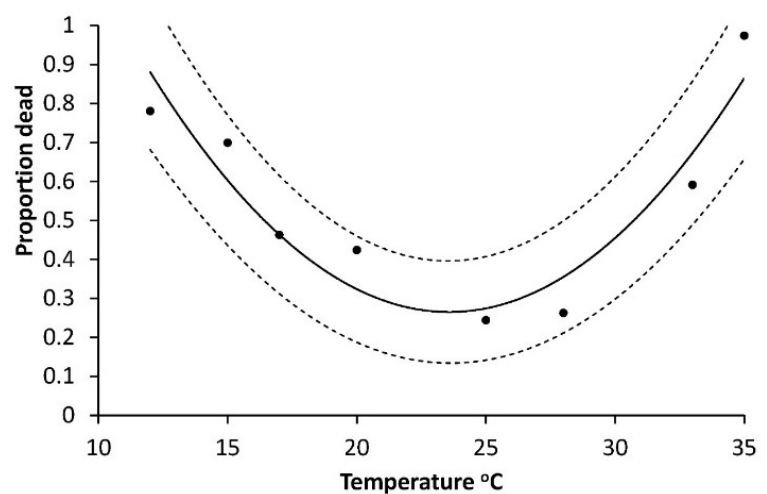
Figure 2. Proportion mortality through of all larval instars (from neonate until pupation) of Agrotis segetum at eight different temperatures. Proportion dead = 2.81957 − 0.2167T + 0.0046T 2 , R 2 = 0.874, F = 17.36, p = 0.0056. The dashed lines above and below represent the upper and lower 95% confidence bands. As it was difficult to categorize a tiny larva as moribund or dead, all moribund larvae were recorded as dead first instars, further supported by lack of head capsules from moulting, and only the precise time of death cannot be given. In contrast, the major mortality at 35 ◦ C was easily observed to take place in the pre-pupal phase. The pupal development rate (R pupa ) also depended strongly on temperature: R pupa = 0.02252 + 0.0040T ( ◦ C), R 2 = 0.925, F = 62.02, p = 0.0005 (Figure 3). This rate was without influence of sex as there was no difference between the two sexes (F = 0.12, p = 0.7397). The base temperature (T 0 ) for pupal development was 5.61 ◦ C and 250 DD over this temperature were required.